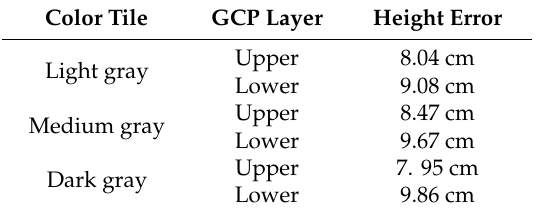
Table 6. Average height errors for lower and upper GCP layers on each color tile.